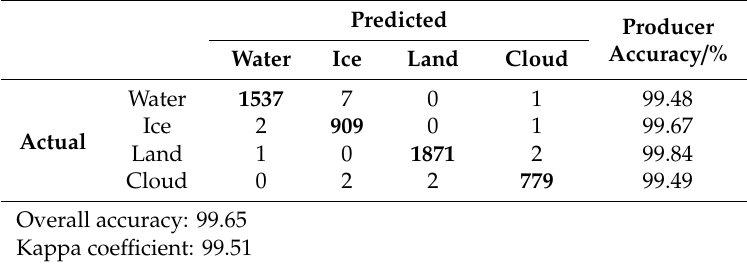
Table A1. Training confusion matrix and accuracy of RF for four classes (The bold count stands for the predicted accurate class results; The accuracy of RF was expressed as the percentage).